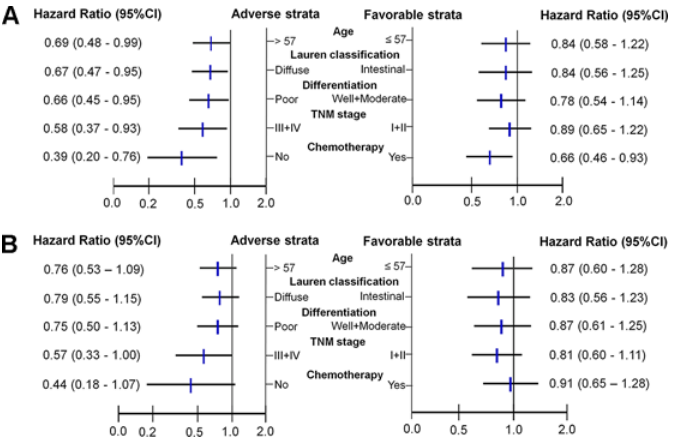
Fig 2. Stratified analyses of the effect of rs1045411 on the outcome of GC patients. Stratified analyses of the associations between genotypes of rs1045411 and OS of GC patients by age, Lauren classification, differentiation, TNM stage and ACT(2A),and the effect on RFS of rs1045411 AG/AA genotypes in the adverse groups (2B). Patient numbers may not add up to 100% of available subjects because of missing genotyping